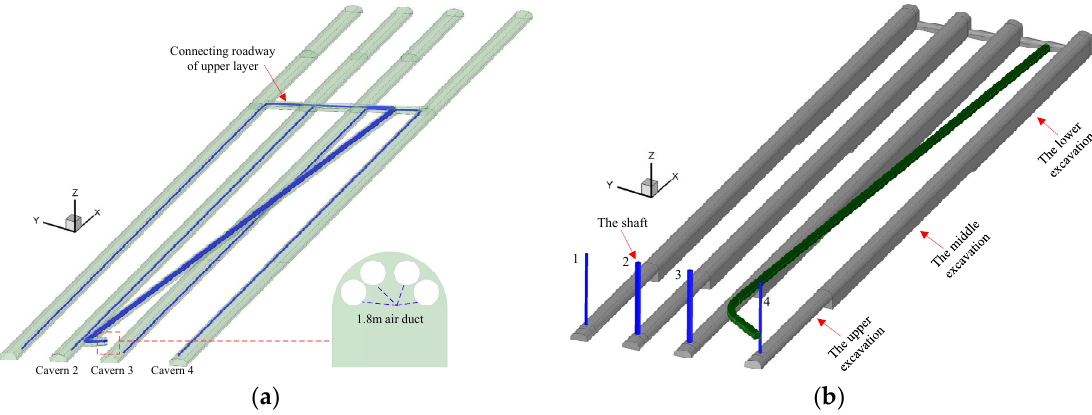
Figure 5. Three-dimensional geometrical model: ( a ) Forced ventilation scheme; ( b ) Axial-flow gallery ventilation scheme.